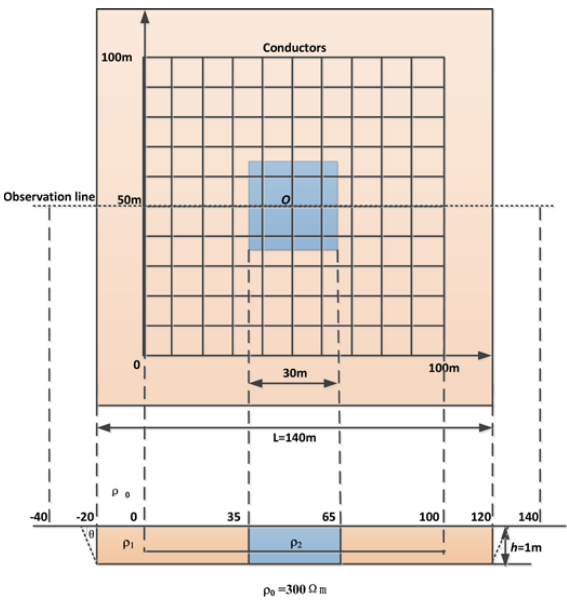
Figure 1. Grounding grid model and backfill material.